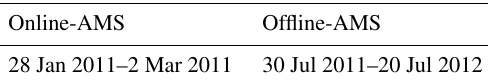
Table 1. Monitoring